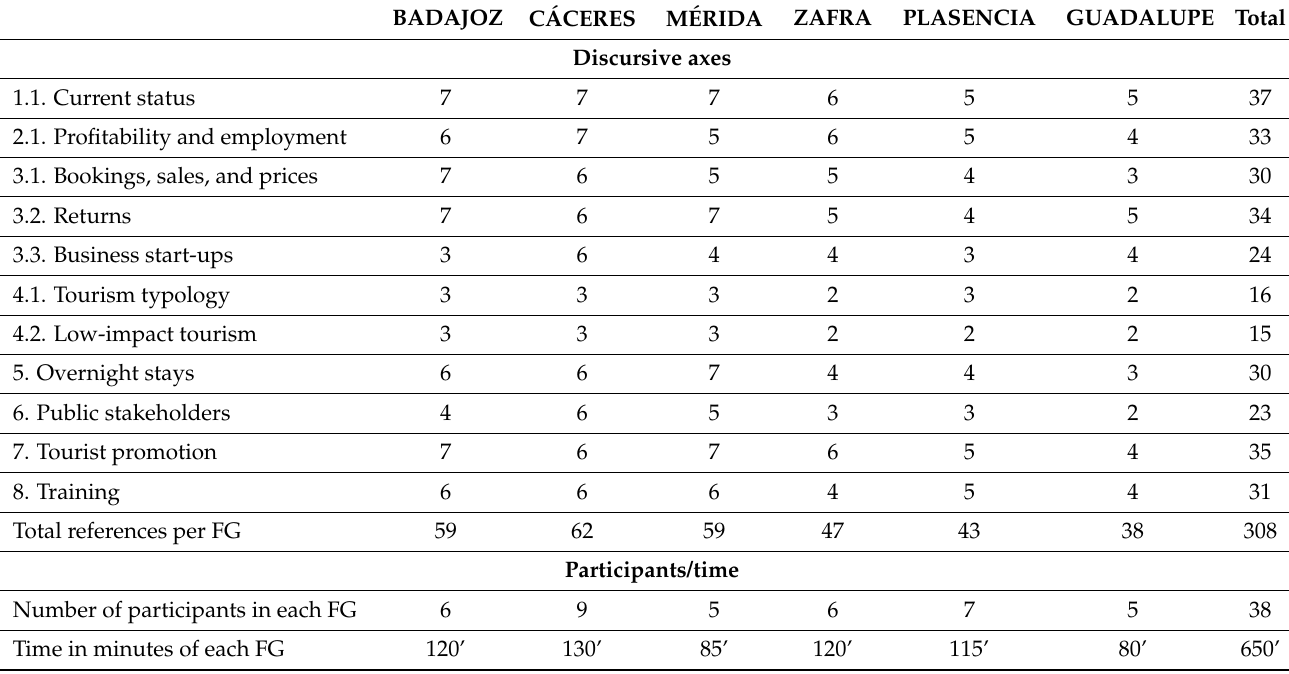
Figure 2. Discursive axes of all focus groups (absolute values: number of mentions). Source: own elaboration. Table 4. Discursive axes (mentions) of the specific focus groups (absolute values).